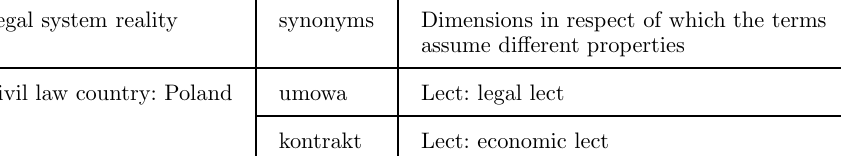
Intrasystemic semantic relation of synonymy at the intralingual level Legal system